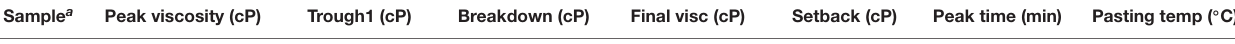
TABLE 5 | Viscosity properties of “Xuzishu8” starch from the different environments. Sample a